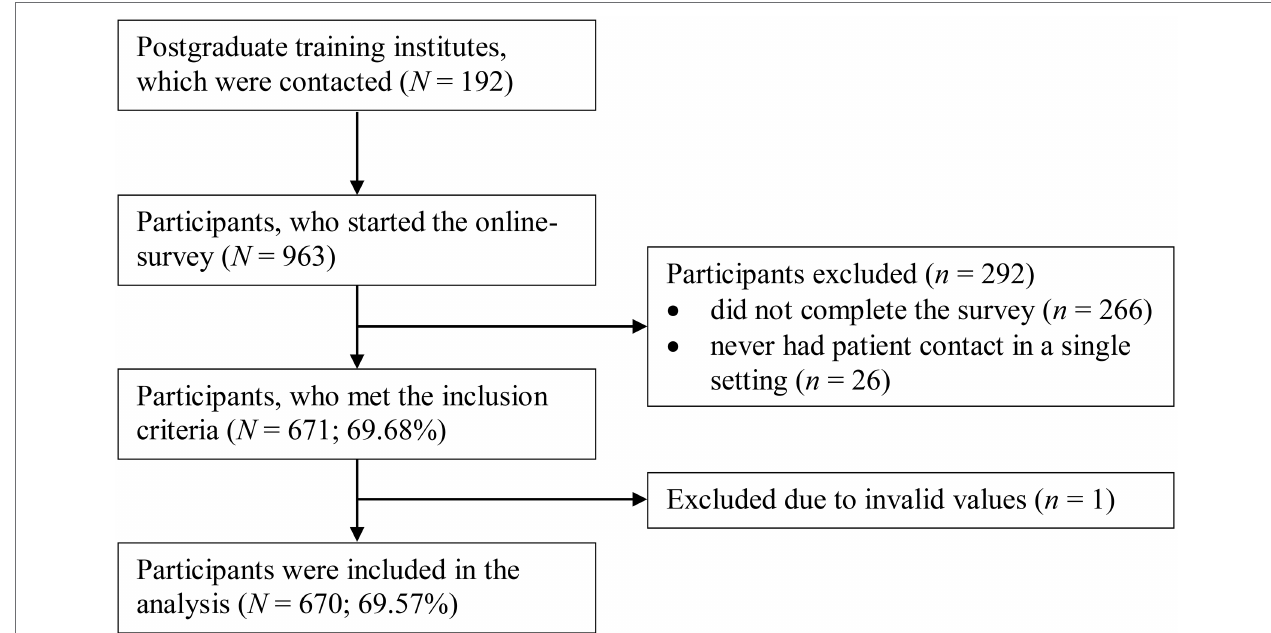
FIGURE 1 | Flowchart of